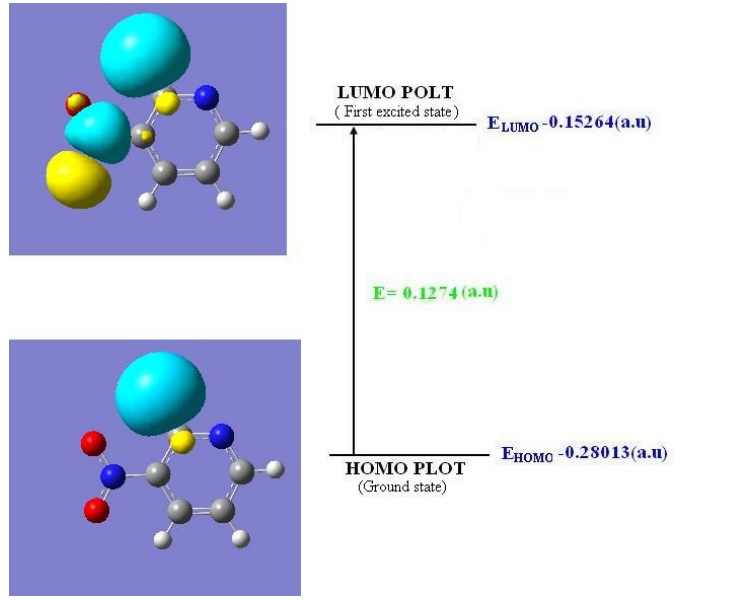
Figure 6 . HOMO and LUMO orbitals and energy plot of ANP.